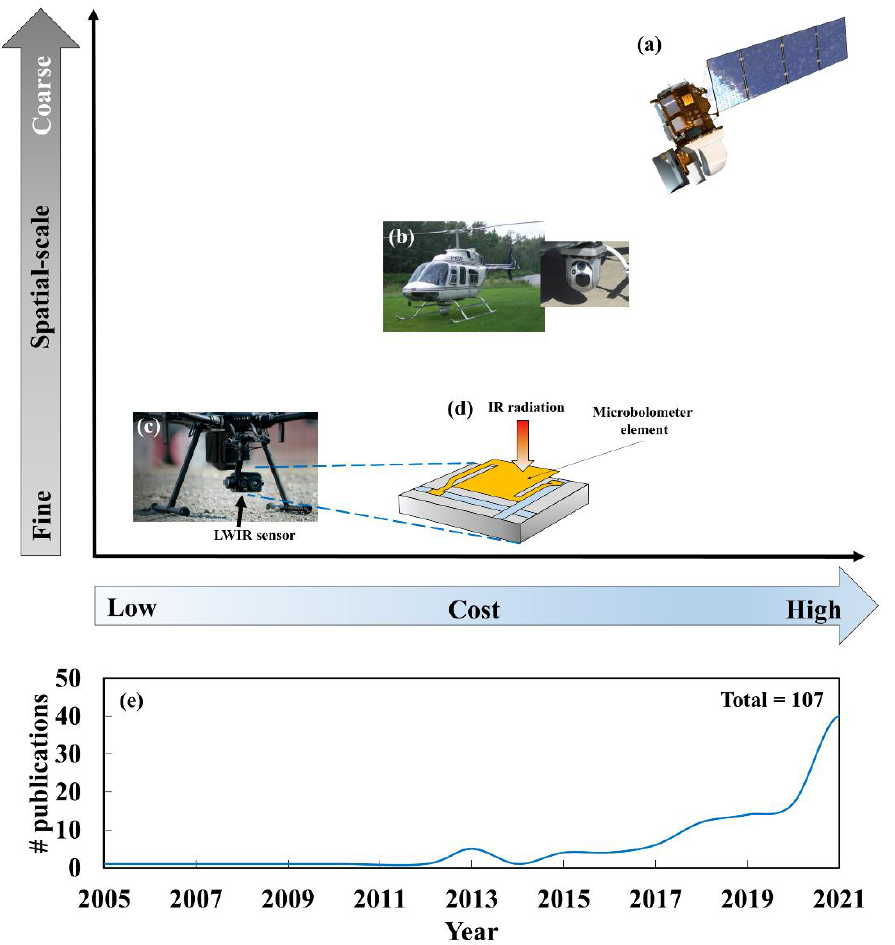
Figure 1. A schematic detailing the thermal infrared (TIR) sensors that are used from coarse to fine spatial-scales and their correspondent costs (( a )satellite, ( b ) airborne, and ( c ) UAV-based). ( d ) A simple conceptual model of a microbolometer. The increase in number of publications with the keywords (UAV + TIR) from a SCOPUS database search is illustrated in ( e ).